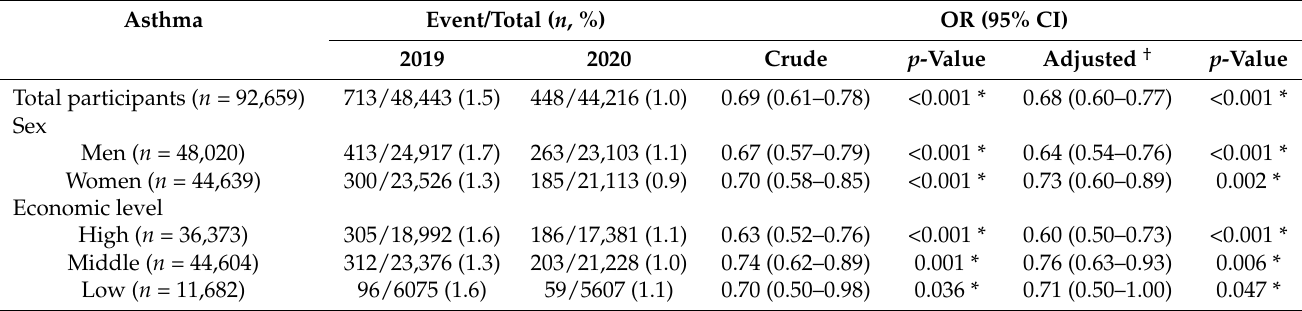
Table 2. Odd ratios of asthma in 2020 compared to those in 2019 in total participants and subgroup.